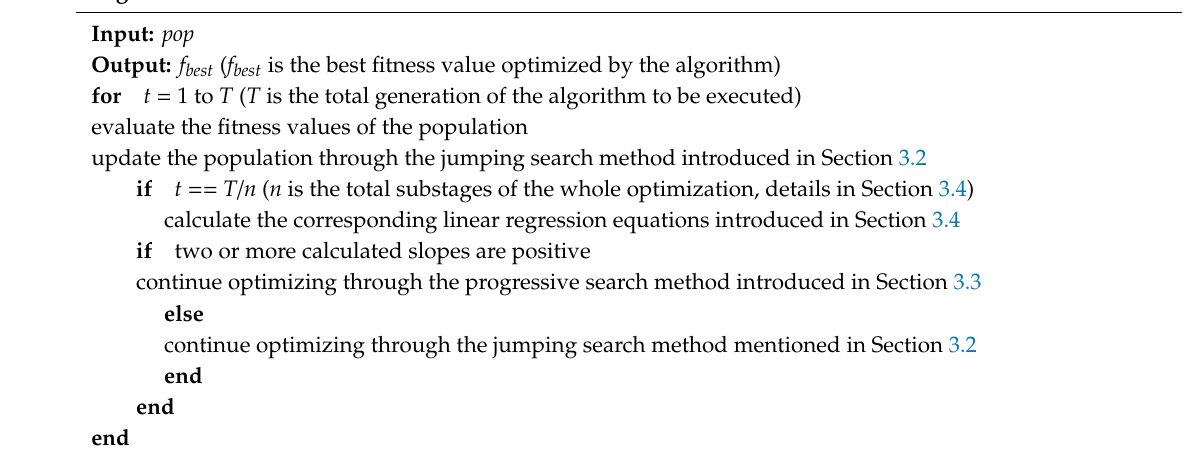
Algorithm 1. Pseudo Code of ISSA